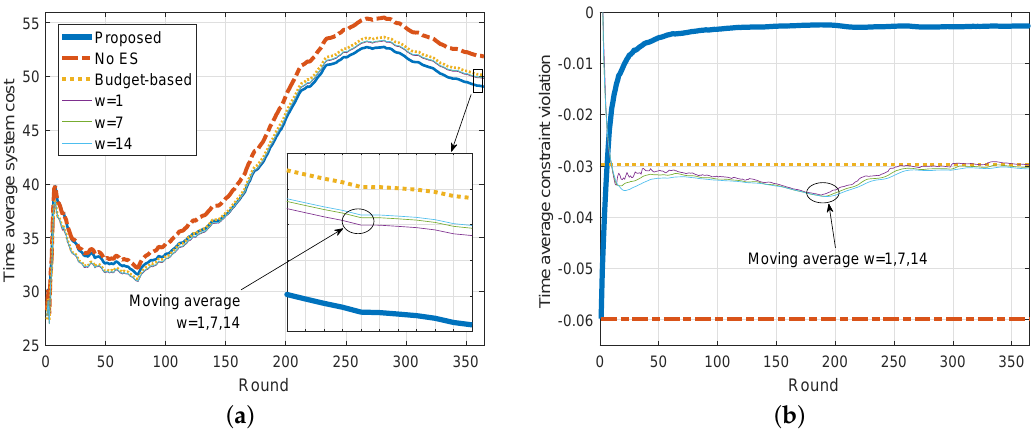
Figure 5. Energy storage capacity allocation performances in the 10-home system. ( a ) Time average system cost. ( b ) The highest time average constraint violation of budget